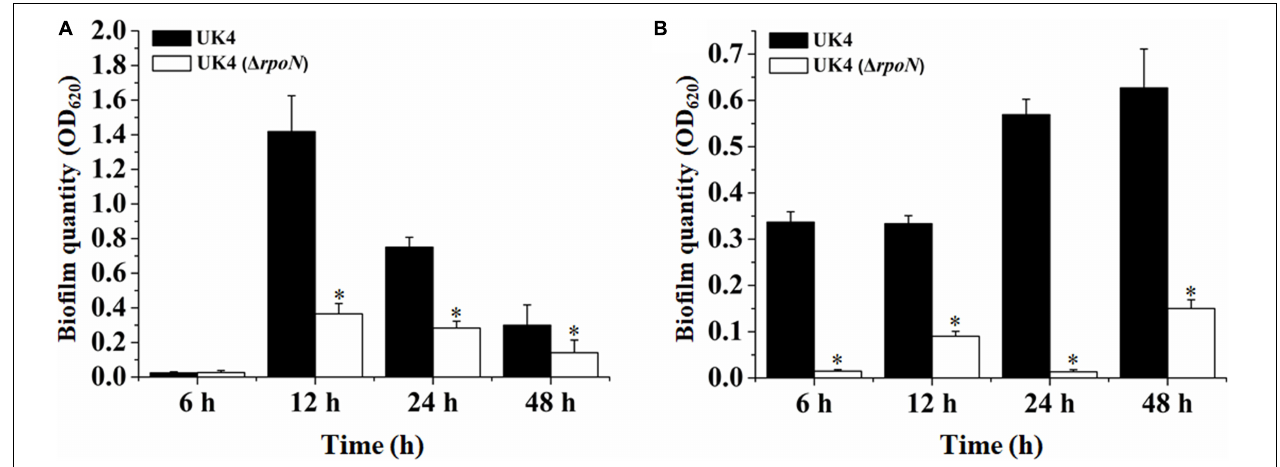
FIGURE 2 | Biofilm biomass of P . fluorescens wild-type strain UK4 and the mutant strain (cid:49) rpoN formed in microplates with LB medium (A) and tryptone broth (B) . The biofilm biomass was quantified by crystal violet staining. Data are expressed as means ± SD of eight replicates. Significant differences between UK4 and the mutant are analyzed by one-way ANOVA (analysis of variance). ∗ p <